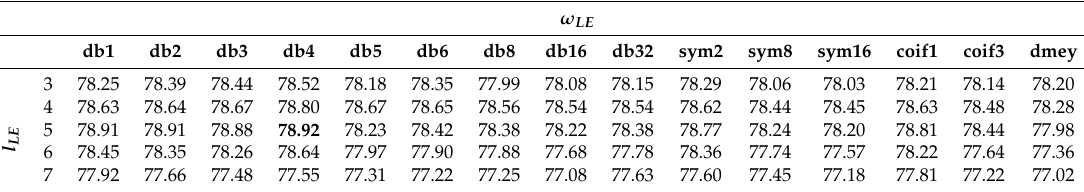
Table 19. The accuracy (%) of six class sleep stage classification with different ω LE and l LE under R&K standard.